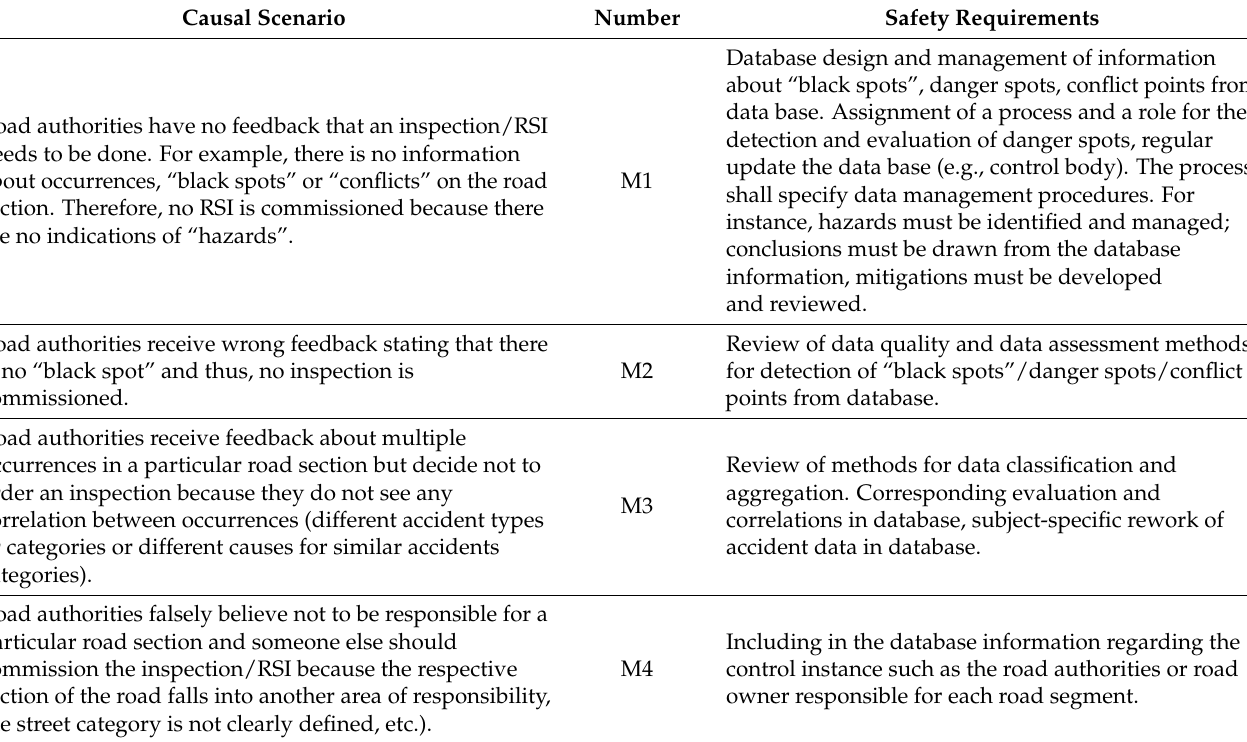
Table 2. Examples of causal scenarios for road authorities ´ unsafe control action (UCA), “omission to commission an inspection or RSI when required”. Causal scenarios and safety requirements are specified in STPA Step